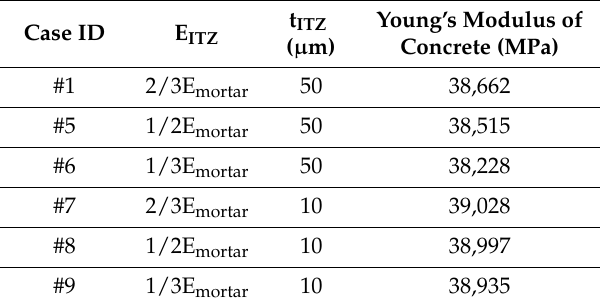
Table 2. Calculated Young’s modulus of concrete with di ff erent ITZ data. E agg = 60 GPa. Mesh: single block, p = 1. Experimental value is 36,360